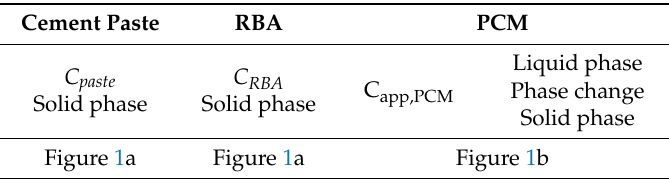
Table 2. Overview of the six PCM-RBA